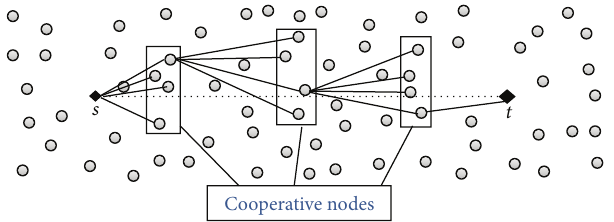
Figure 2: Multihop mesh cooperative structure for data dissemina- tion in WSNs.